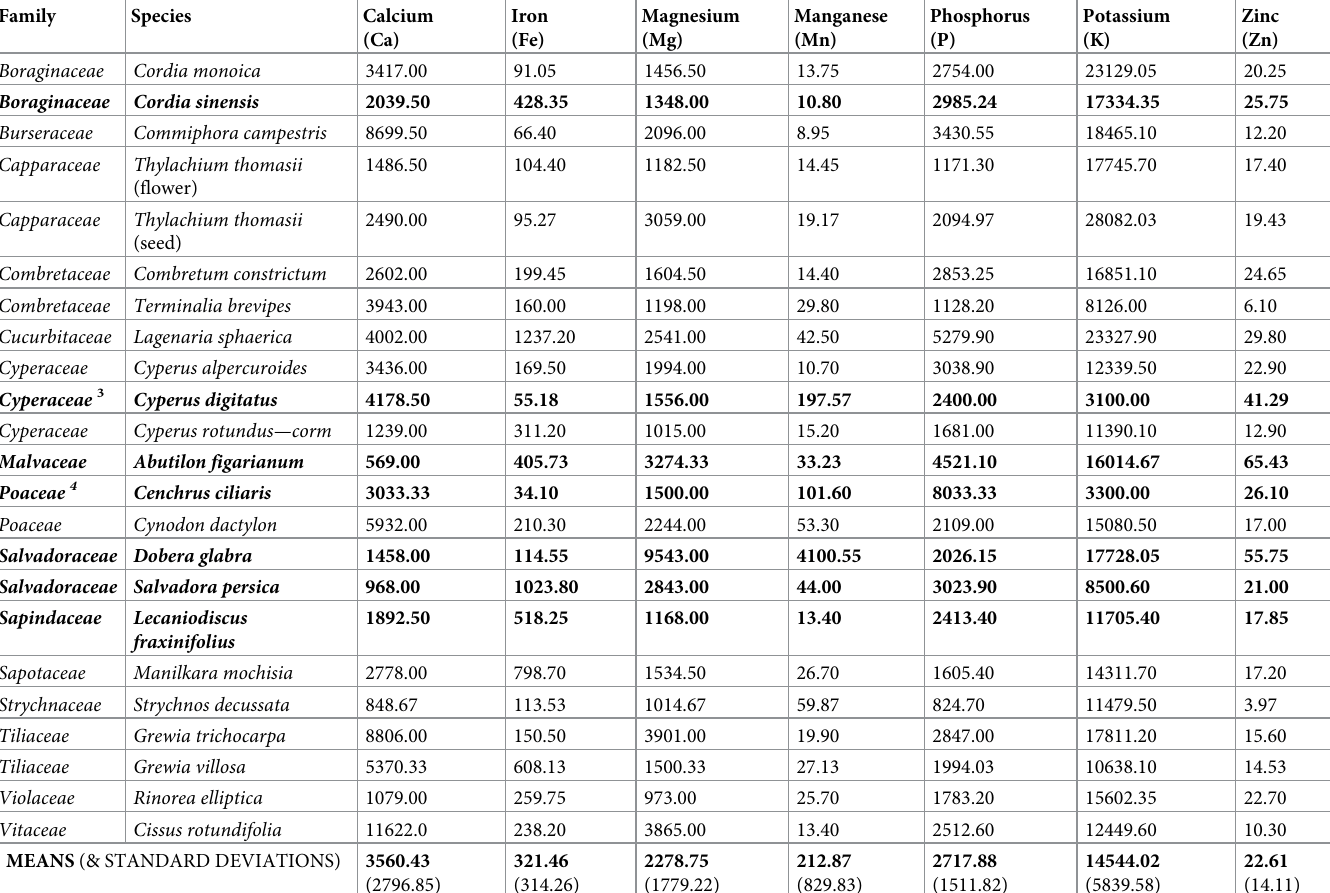
Table 4. Mchelelo baboon dietary mineral content (mg/kg [DM])–savanna samples